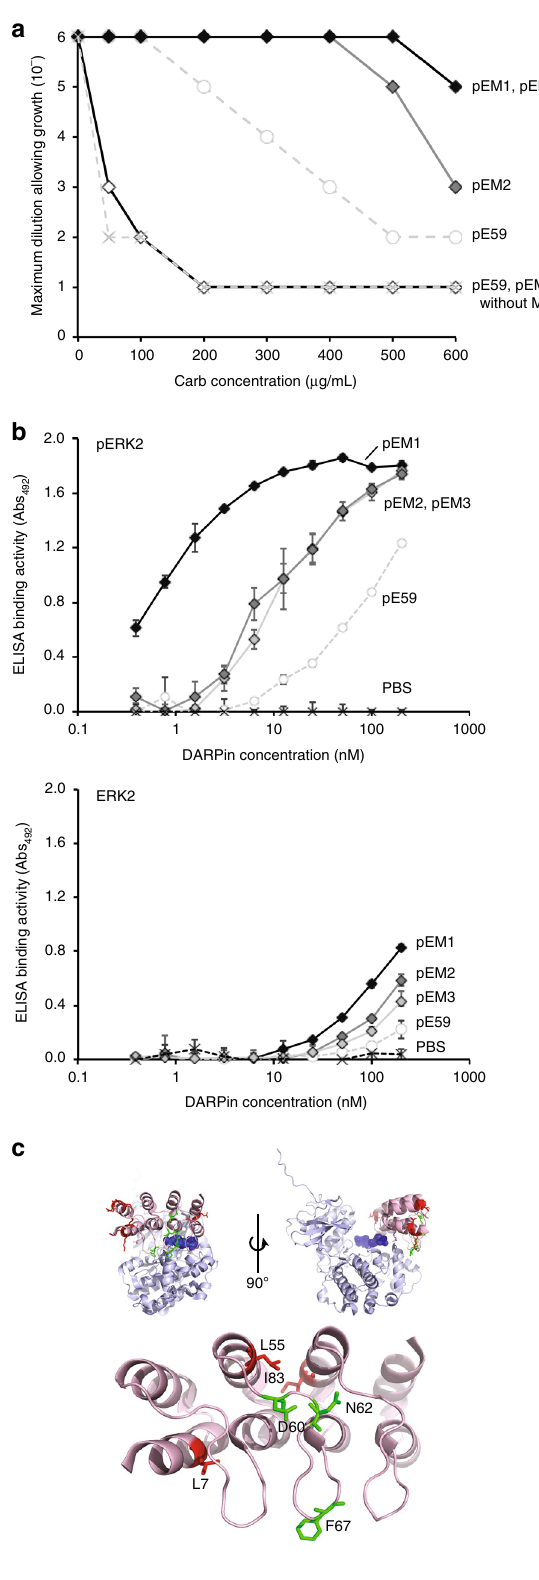
Fig. 4 Isolation of DARPin variants with enhanced pERK2 af fi nity. a Survival curves for serially diluted E. coli MC4100 cells co-expressing TatABC along with ERK2-Bla and Tat-targeted DARPins pEM1 (light gray), pEM2 (dark gray), and pEM3 (black). Resistance of cells was evaluated in the presence ( fi lled diamonds) or absence (empty diamonds) of MEK1 R4F kinase. Overnight cultures were serially diluted in liquid LB and plated on LB agar supplemented with Carb. Maximal cell dilution that allowed growth is plotted versus Carb concentration. Resistance pro fi les for pERK2-speci fi c DARPin pE59 are shown with (empty circles) and without (light gray x marks) MEK1 R4F for comparison. b ELISA binding activity for puri fi ed DARPins pE59, pEM1, pEM2, and pEM3 against immobilized pERK2 (top) or ERK2 (bottom). PBS served as a negative control. All data are the average of three biological replicates and the error bars represent the standard deviation (SD). c Location of mutations in DARPin variants pEM1, pEM2, and pEM3 mapped onto the pE59-pERK2 co-crystal structure. The structure was derived from PDB ID 3ZUV described in Kummer et al. 30 , and the schematic was generated using PyMOL software. The DARPin is shown in light red, pERK2 in light blue, the phosphorylated T185 and Y187 active site residues of ERK2 in dark blue spheres, and the mutations found in helix and loop secondary structures in red and green, respectively. Source data for this fi gure is available in the Source Data File